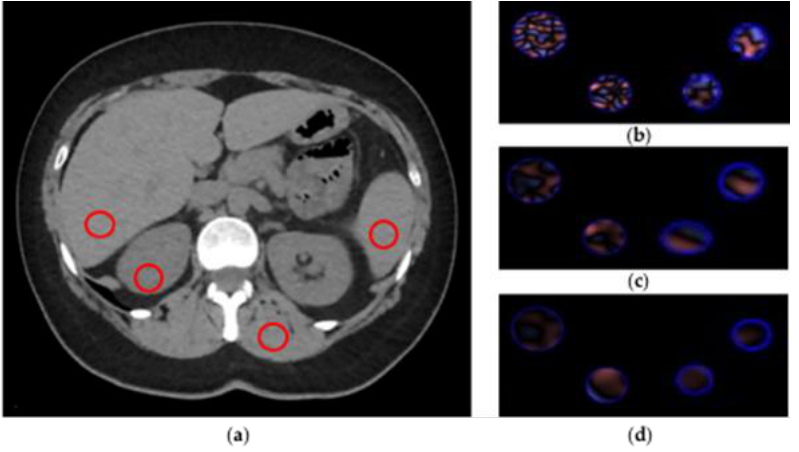
Figure 3. CT texture analysis (CTTA) process. ( a ) Regions of interest (ROIs) placement. ( b – d ) Filtration-histogram statistic-based method corresponding to fine, medium and coarse texture scale of ROIs (area 1 cm 2 ), respectively.